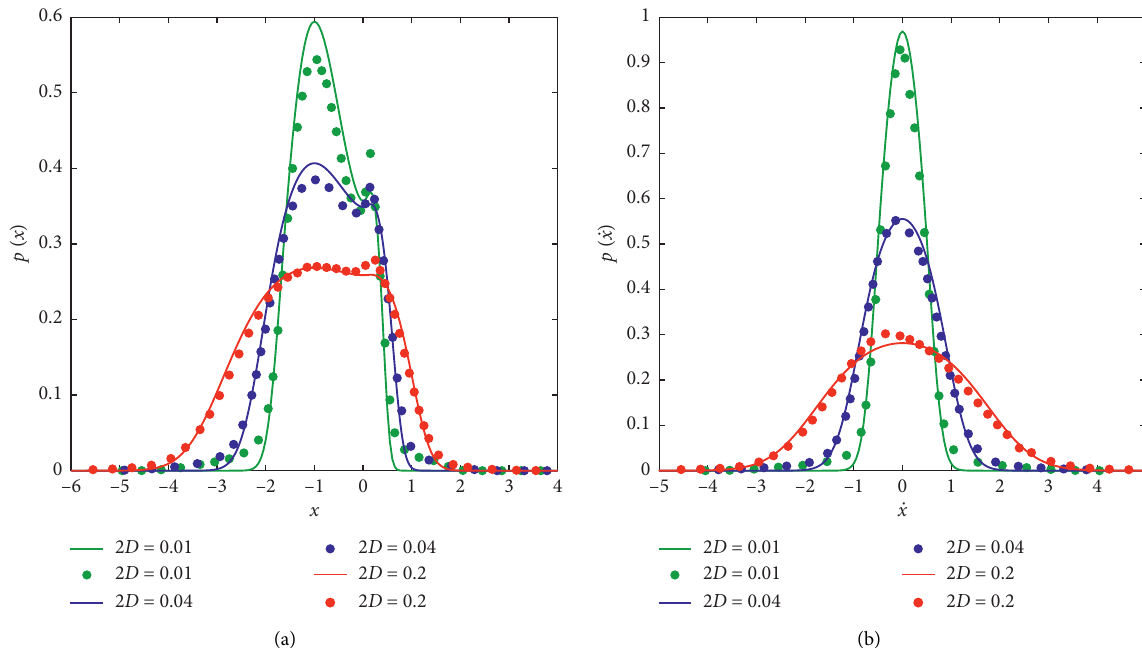
Figure 7: The PDF of the nonlinear system under different Gaussian white noise intensities 2 D . (a) The displacement PDF; (b) the velocity � − 1, solid lines: the analytical results, and circles: MCS results). PDF ( k 1